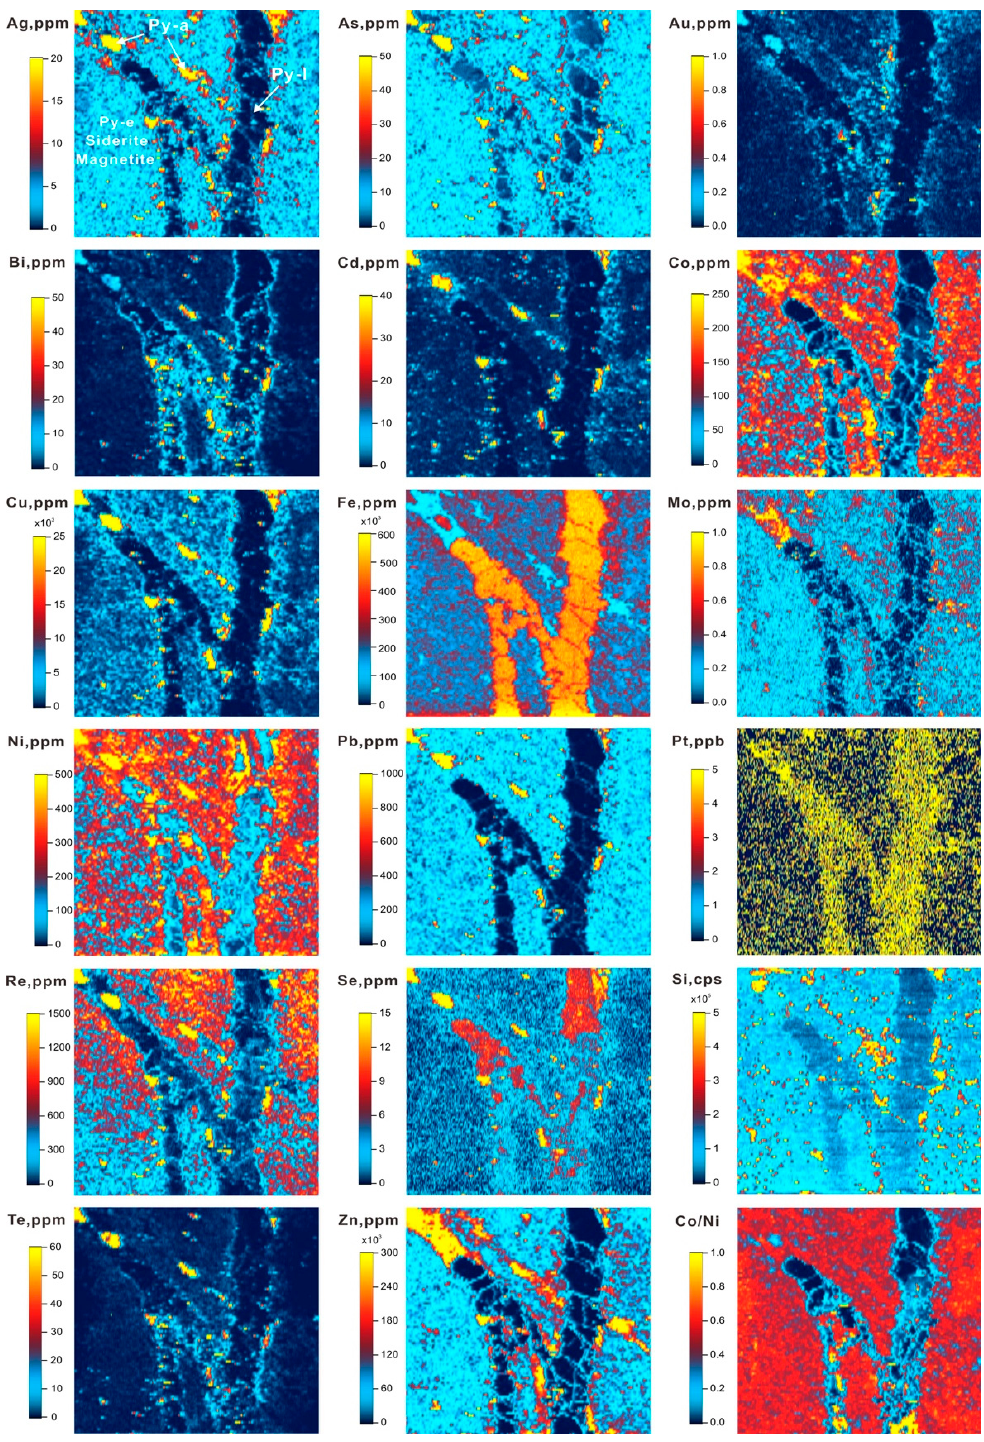
Figure 4. LA-Q-ICP-MS element maps. The elements are arranged in alphabetical orders. Se, Co, Ni and Co/Ni ratios are inhomogeneous in Py-l. Ag, As, Au, Bi, Cd, Co, Cu, Mo, Ni, Pb, Re, Se, Si, Te and Zn are hosted within the sulfide assemblages, which are always distributed around Py-l, or in the fracture. Py-l is barren of these metals, but is relatively enriched in Pt and Se. The resolution of these images is not high enough to distinguish Py-e from siderite and magnetite. Spot results are shown in Figure 5. The area mapped is approximately the same as that indicated by the red square in Figure 1a. Sulfur isotopes are also mapped in this same area. The sample block was carefully polished after S isotope analysis in preparation for trace element mapping.